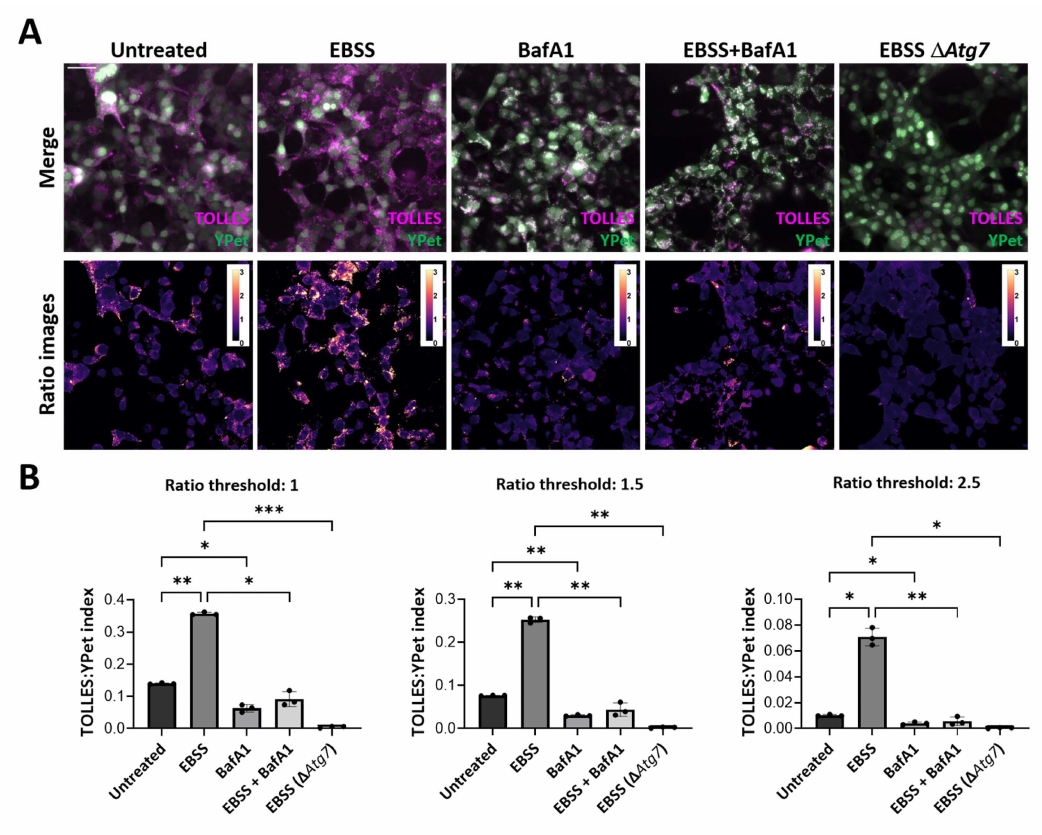
Figure 2. Quantification of SRAI ratio as a reliable measure of autophagic flux. ( A ) Representative immunofluorescence merge images of TOLLES (magenta) and YPet (green) from Figure 1C and their corresponding ratio images generated using the developed ImageJ macro. Bar = 50 µ m. ( B ) Quantifi- cation of the TOLLES:YPet index from A using different set up thresholds employing ratios higher than 1; 1.5 and 2.5 ( n = 3, 6 fields per replicate were analyzed with 60–100 cells per field, ± S.D., * = p < 0.05, ** = p < 0.01, *** = p < 0.001, 1-way ANOVA followed by Holm-Š í d á k